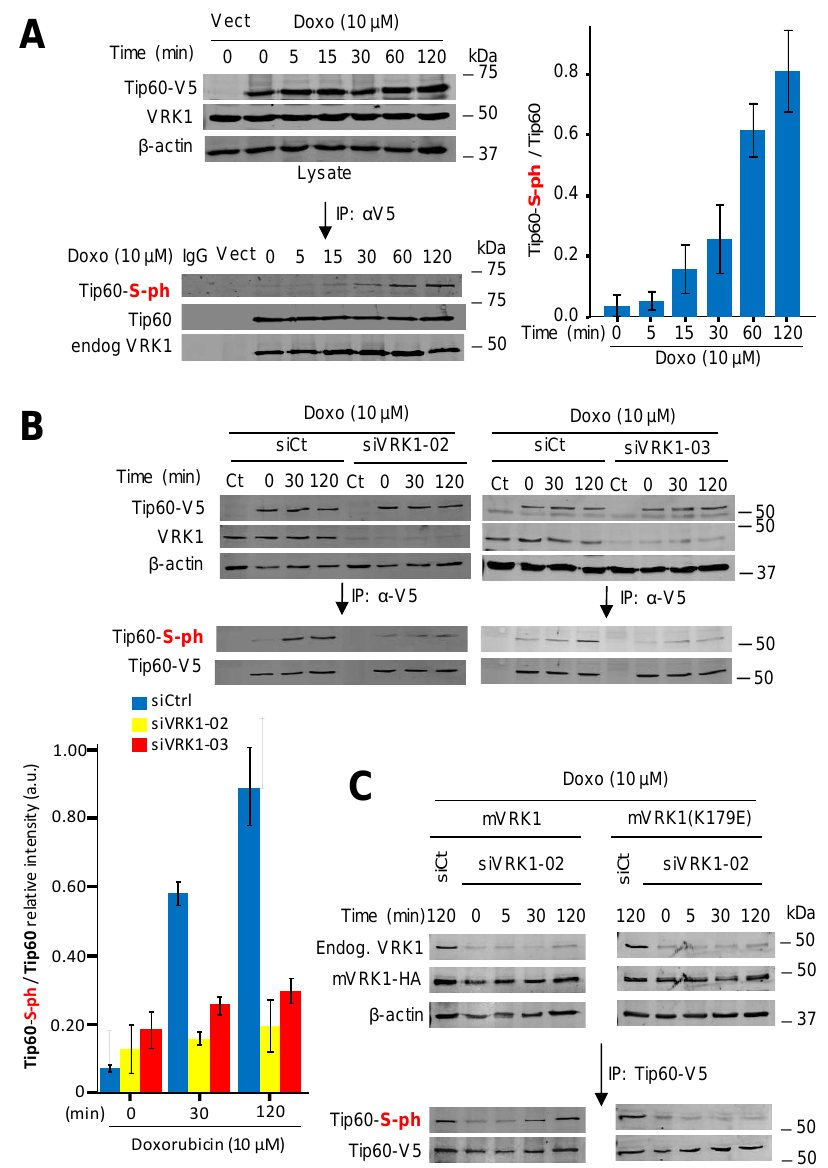
Figure 4. VRK1 mediates the phosphorylation of Tip60 induced by doxorubicin. ( A ). Time dependent phosphorylation of Tip60 in cells treated with doxorubicin. A549 cells were transfected with plasmid Tip60-V5 or empty vector (Ct); and to eliminate mitogenic signaling, cells were maintained in 0.5% serum for 48 h before the addition of doxorubicin to the culture. Cells were lysed at di ff erent time points and Tip60 was immunoprecipitated and determined its stable interaction with endogenous VRK1. The phosphorylation of the Tip60 after doxorubicin treatment and present in the immunoprecipitated Tip60-VRK1 complex was detected in Western blots. To the right it is shown the quantification from three independent experiments. Vect: Transfected with empty vector. Vect: Transfection control with empty vector. ( B ). E ff ect of VRK1 depletion on the phosphorylation of Tip60. A549 cells were treated with si-control (left), siVRK1-02 (center) or siVRK1-03 (right) followed by transfection with plasmid Tip60-V5, and cells were treated with doxorubicin at the indicated times. Transfected Tip60-V5 was immunoprecipitated and the phosphorylation of Tip60 determined in Western blots. The graph to the bottom-left shows the quantification of phosphorylated Tip60 from three different experiments. Vect: Transfected with empty vector. ( C ). Rescue of Tip60 phosphorylation induced by doxorubicin in two A549 stable cell lines expressing either murine kinase-active (left) or kinase-dead murine VRK1 (K179E) (right) in which endogenous human VRK1 was depleted. Experiments were repeated three